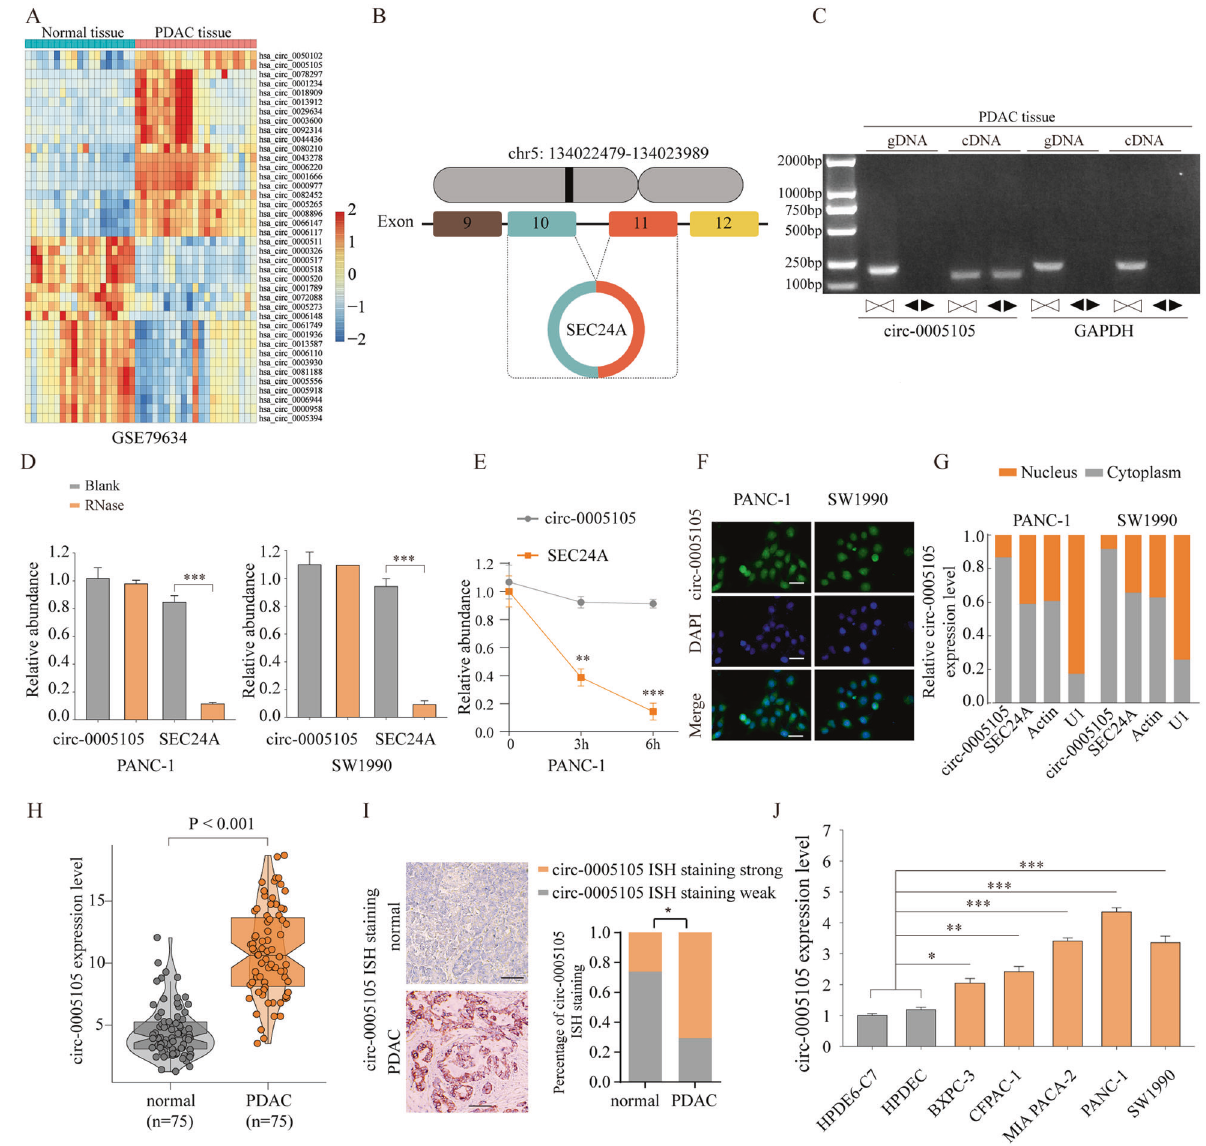
Fig. 1 CircRNA circ-0005105 is overexpressed in PDAC tissues. A Heat maps of differently expressed circRNAs in PDAC tissue compared with adjacent normal tissue (GSE79634). Red indicates a higher fold-change and blue indicates a lower fold change. B circ-0005105 is produced at the SEC24A gene locus containing exon 9-12. C . RT-PCR assay with divergent or convergent primers indicated the existence of circ-0005105 in PDAC tissue. GAPDH was used as a negative control. qRT-PCR analysis of the expression of circ-0005105 after RNase R treatment ( D ) and Actinomycin D ( E ). The subcellular localization of circ-0005105 in PANC-1 and SW1990 cells were analyzed through fl uorescence in situ hybridization (FISH) ( F ) and nuclear and cytoplasmic separation assay; Scale bar = 40 μ m ( G ). The expression of circ-0005105 in 75 pairs of PDAC (Tumor) and adjacent normal tissues (Normal) was determined by qRT-PCR ( H ) and in situ hybridization (ISH); Scale bar = 400 μ m ( I ). qPCR analysis of circ-0005105 expression in pancreatic epithelial cells (HPDE6-C7 and HPDEC) and pancreatic cancer cells (BXPC-3, CFPAC-1, MIA PACA-2, PANC-1, and SW1990). The results are presented as the mean ± SD. * P < 0.05, ** P < 0.01, *** P <